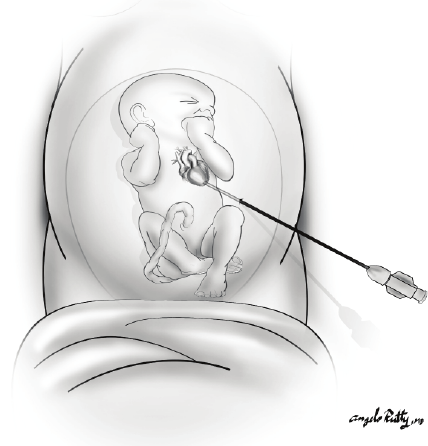
Figure 2: Illustration of the correct needle trajectory through the maternal abdomen and into the fetal left ventricle at the apex.